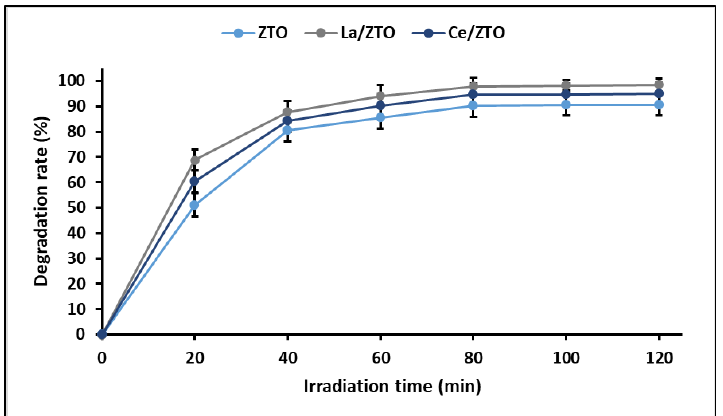
Figure 9. Photocatalytic cyanide degradation by the nanoparticles.